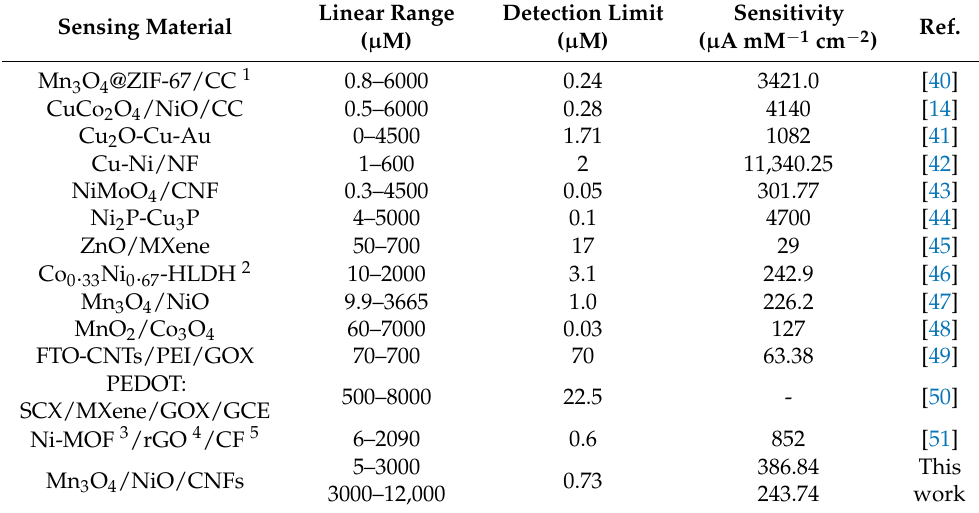
Table 1. Performance comparison of the proposed Mn 3 O 4 /NiO/CNFs/GCE with other glucose